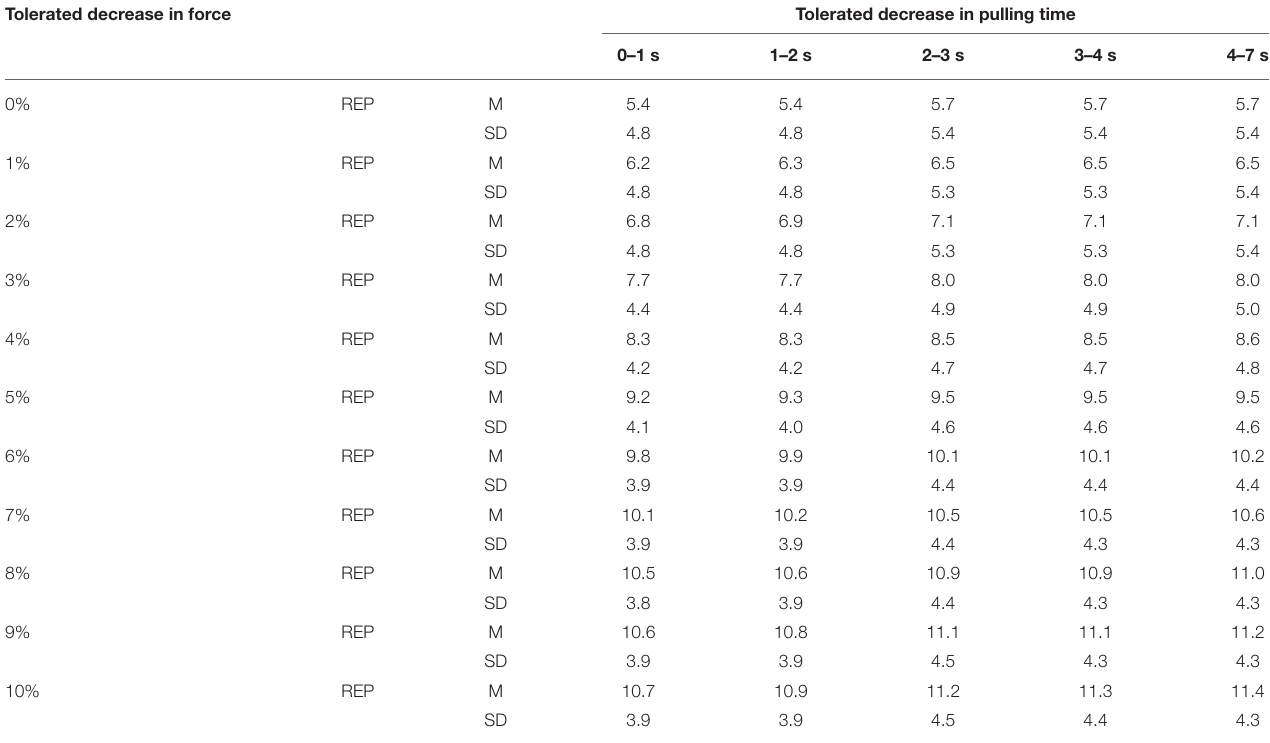
TABLE 5 | Number of repetitions for different criteria of a “valid” repetition in men. Tolerated decrease in